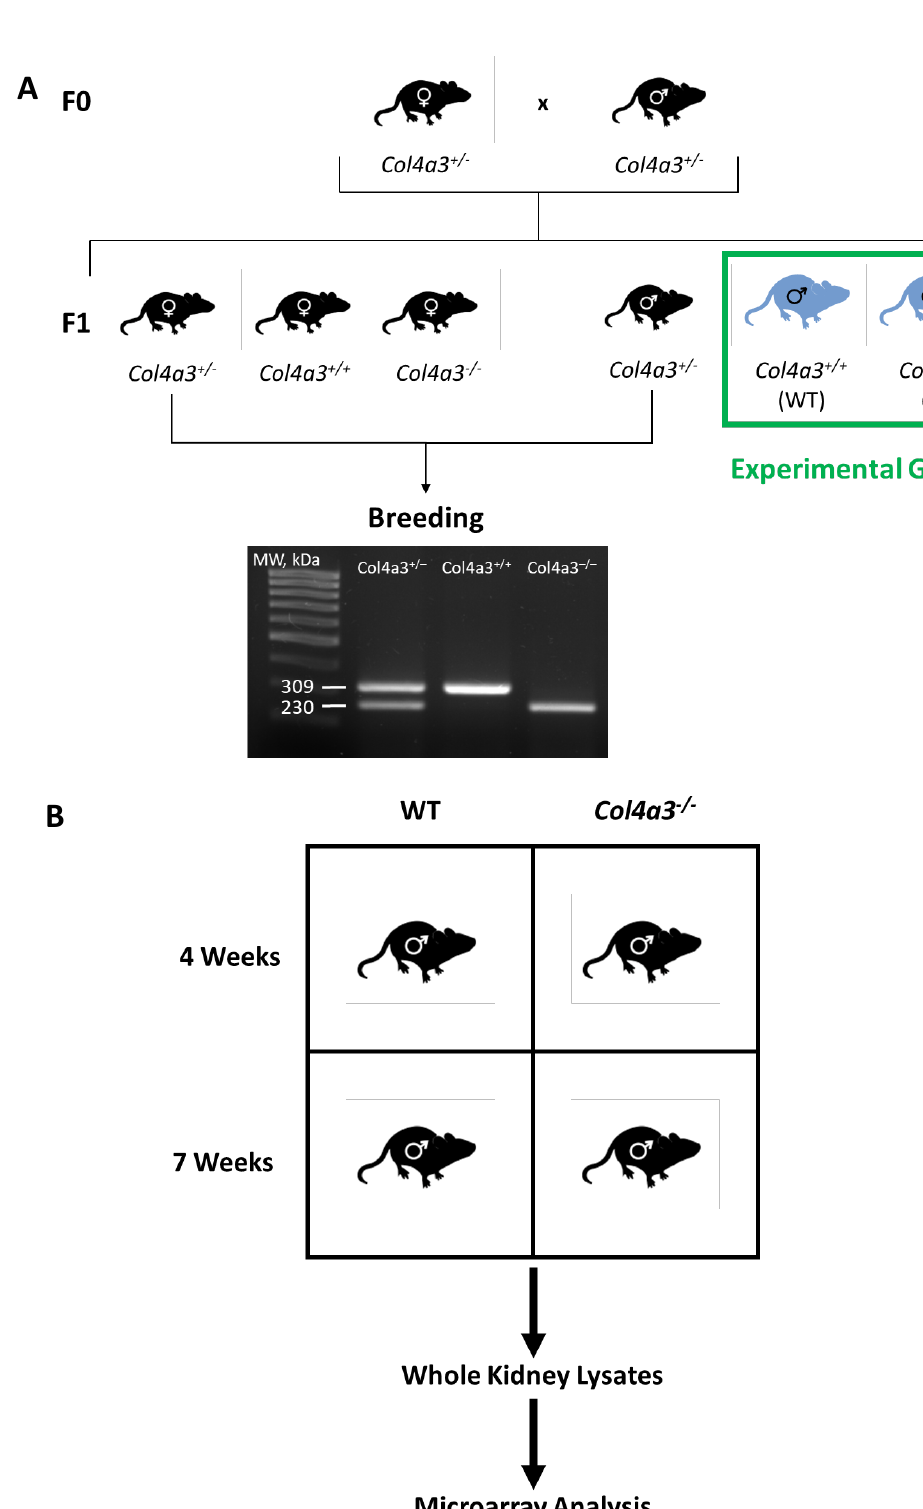
Figure 1. Schematic diagram summarizing experimental workflow. ( A ) breeding strategy for generating experimental groups for analysis. ( B ) Whole kidney samples from 4 and 7 week old wild type (WT) and Col4a3 -/- (KO) mice were subjected to microarray expression profiling. Table 1. Clinical characteristic for Alport and wild-type mice.